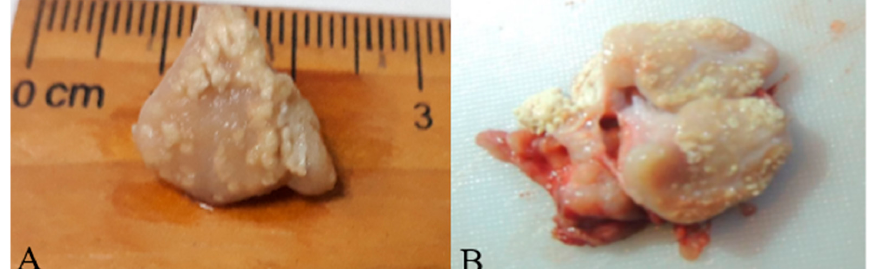
Figure 1. Type-1 TBLL necrotic/miliary ( A ) and type-4 TBLL cavitation lesion in submandibular lymph node ( B ) in adult wild boar.